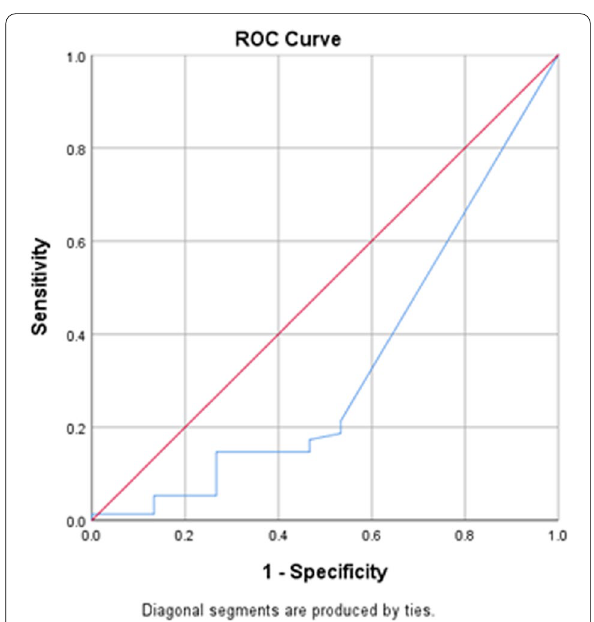
Fig. 3 ROC curve analysis of our selected cutoff